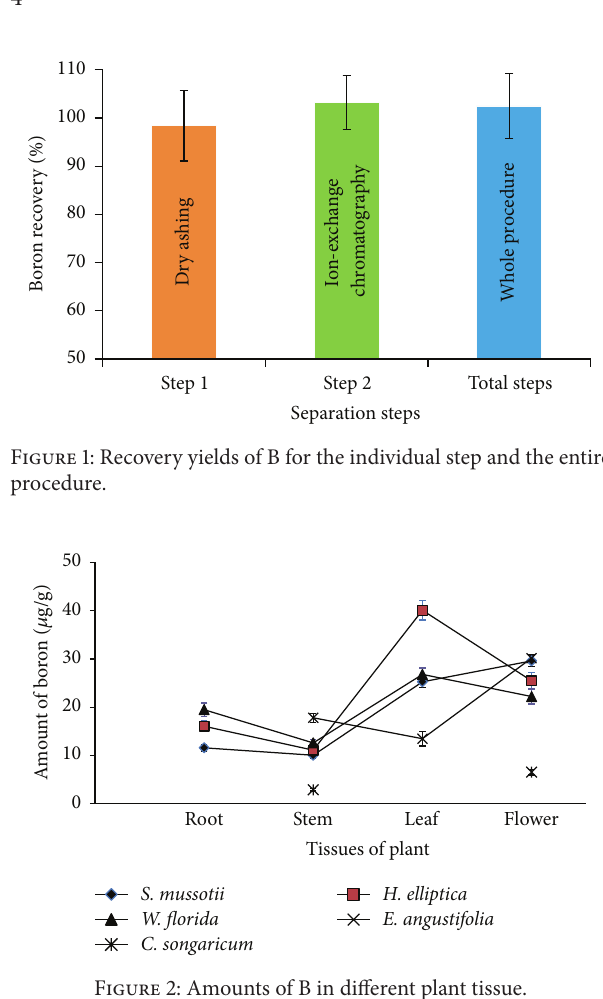
Figure 2: Amounts of B in different plant tissue.